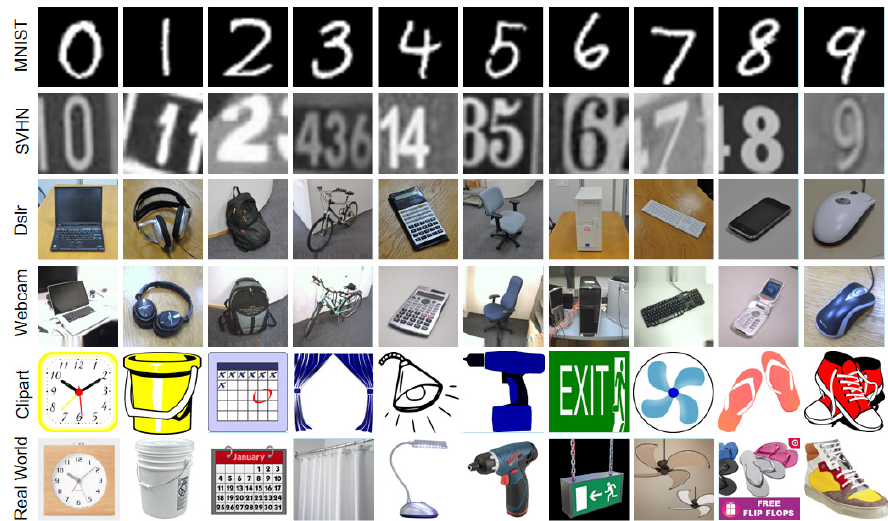
Figure 3. Sample images from three experimental datasets are illustrated. From the top line to the bottom line, these partial pictures were formulated on the original sets of MNIST, SVHN, Office-31 and